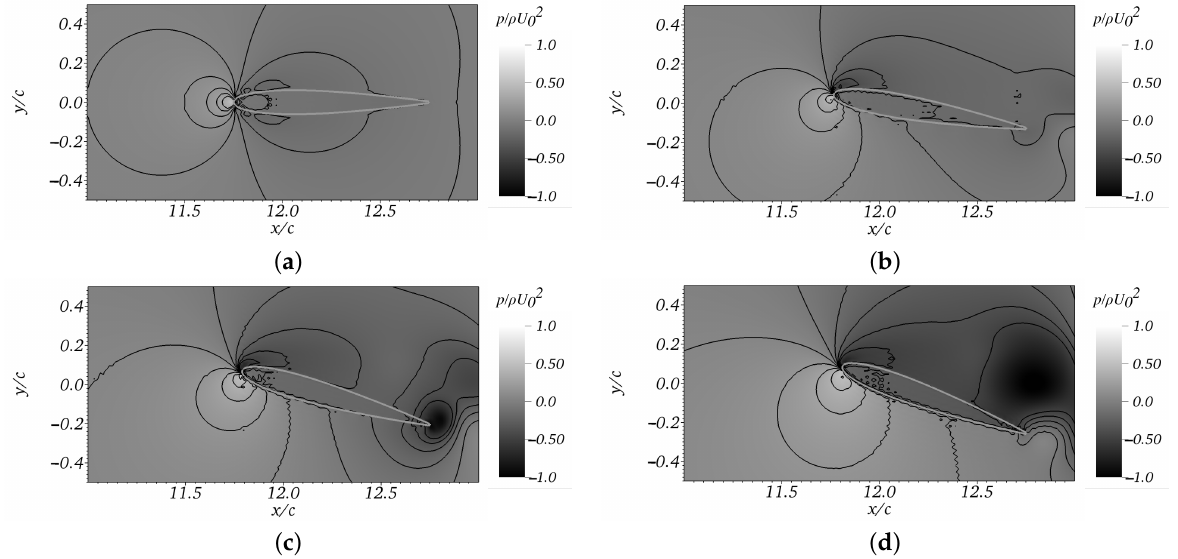
Figure 12. Isolines of pressure fields, at t ∗ = 80: ( a ) α = 0 ◦ , ( b ) α = 10 ◦ , ( c ) α = 16 ◦ and ( d ) α = 20 ◦ .